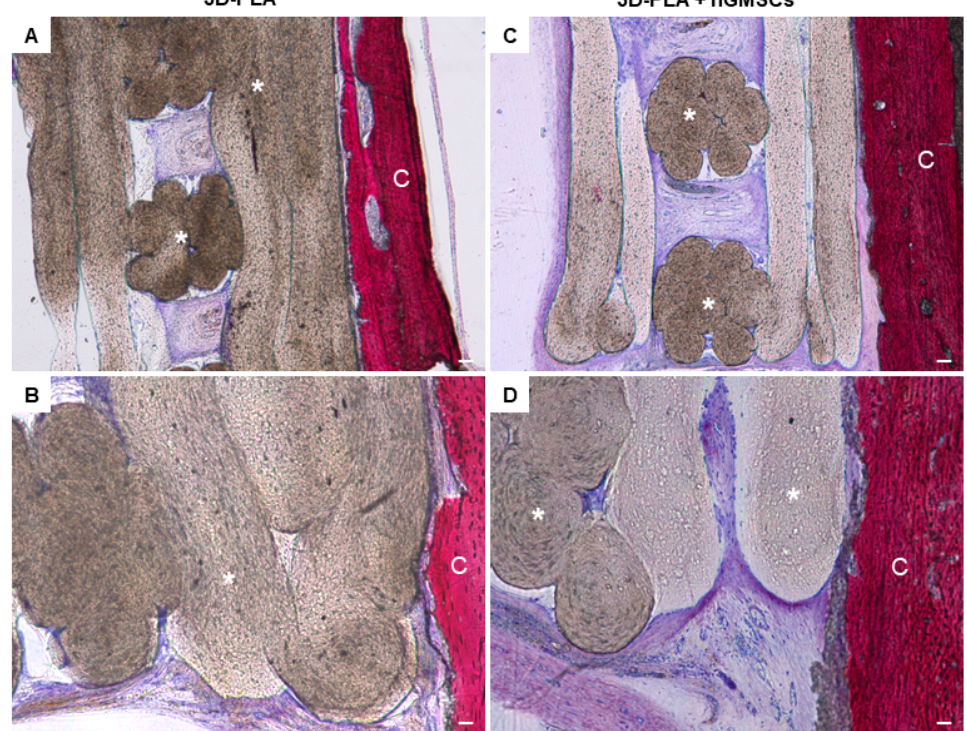
Figure 5. Histological examination of 3D-PLA group and 3D-PLA + hGMSCs group. Representative methylene blue and acid fuchsin images. ( A ) 3D-PLA group at low magnification (4×); ( B ) 3D-PLA group at high magnification (20×); ( C ) 3D-PLA + hGMSCs group at low magnification (4×); ( D ) 3D-PLA + hGMSCs group at high magnification (20×). Scale bars represent 10 μ m. *: 3D-PLA scaffold; C: rat calvaria.